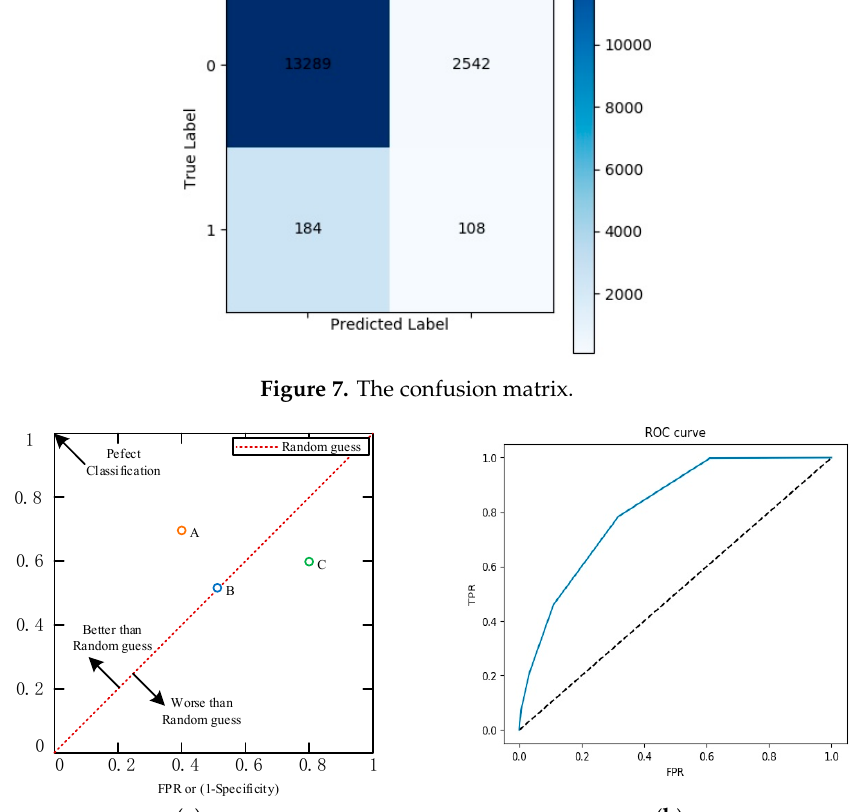
Figure 8. ROC-AUC curves. ( a ) Comparison of different ROC-AUC curves. ( b ) The ROC curve of the proposed model.